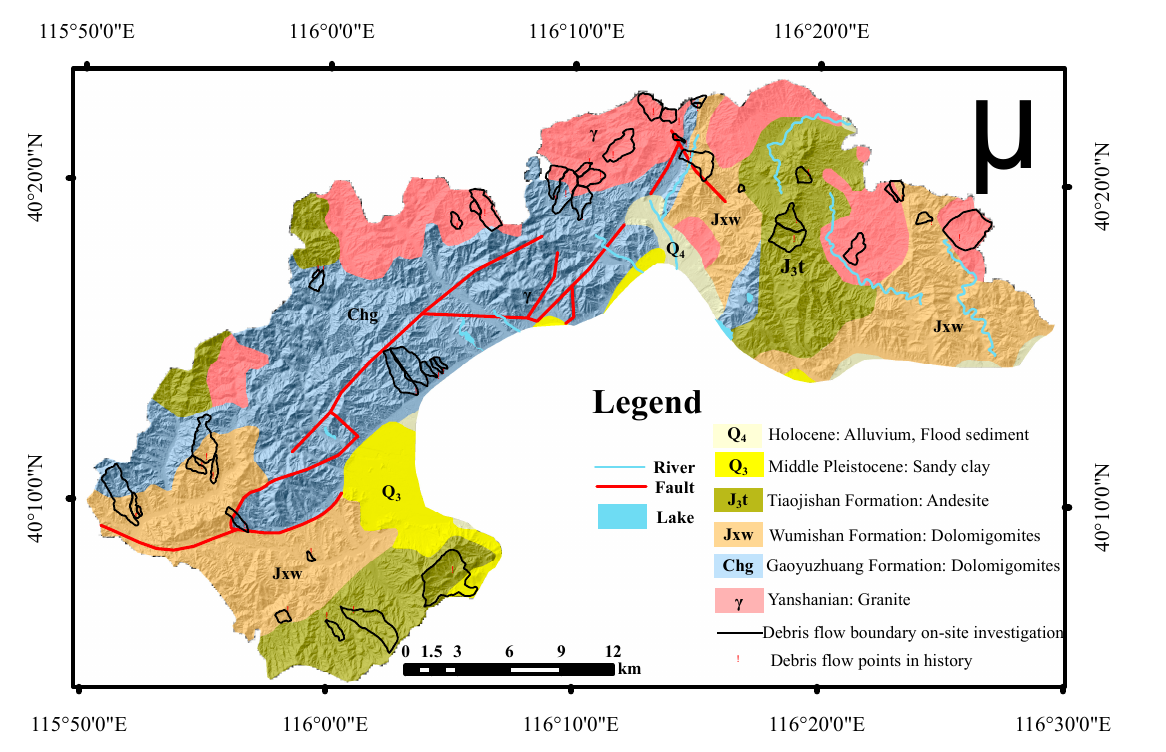
Figure 2. The geological and tectonic map of the study area.